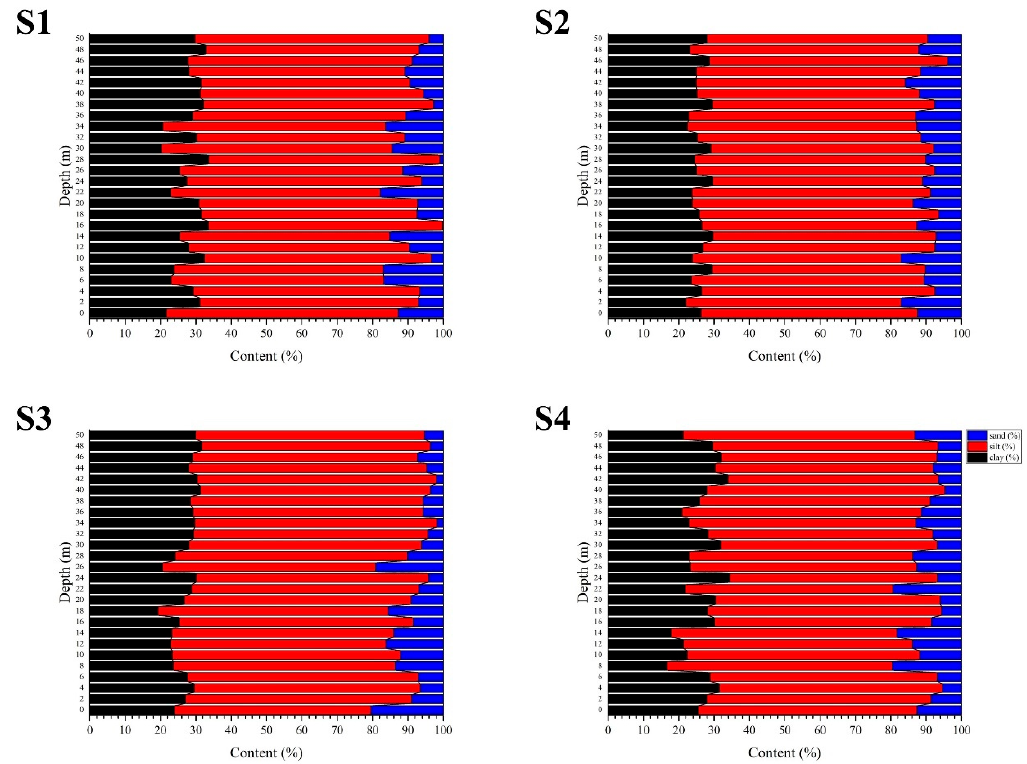
Figure 3. Profiles of the grain size in the sediment. S1-4 present the sampling sites in Figure 1.